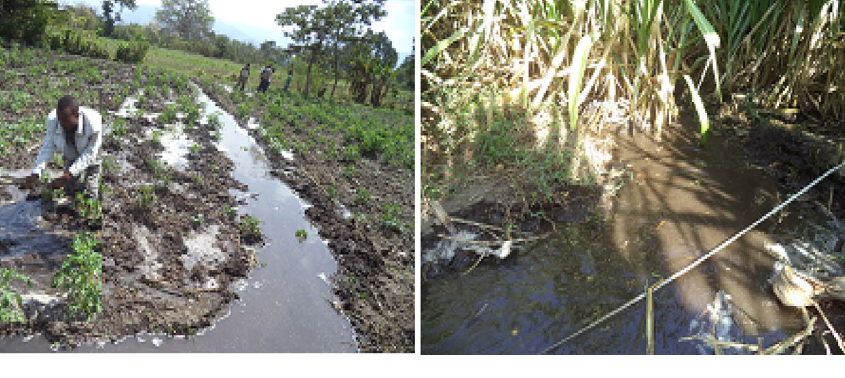
Table 4 Surface irrigation water potential based on field crops in Cheleleka watershed, Central Rift Valley, Ethiopia